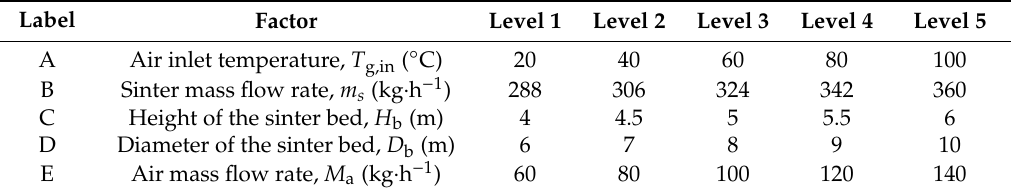
Table 6. Parameters and levels considered in this